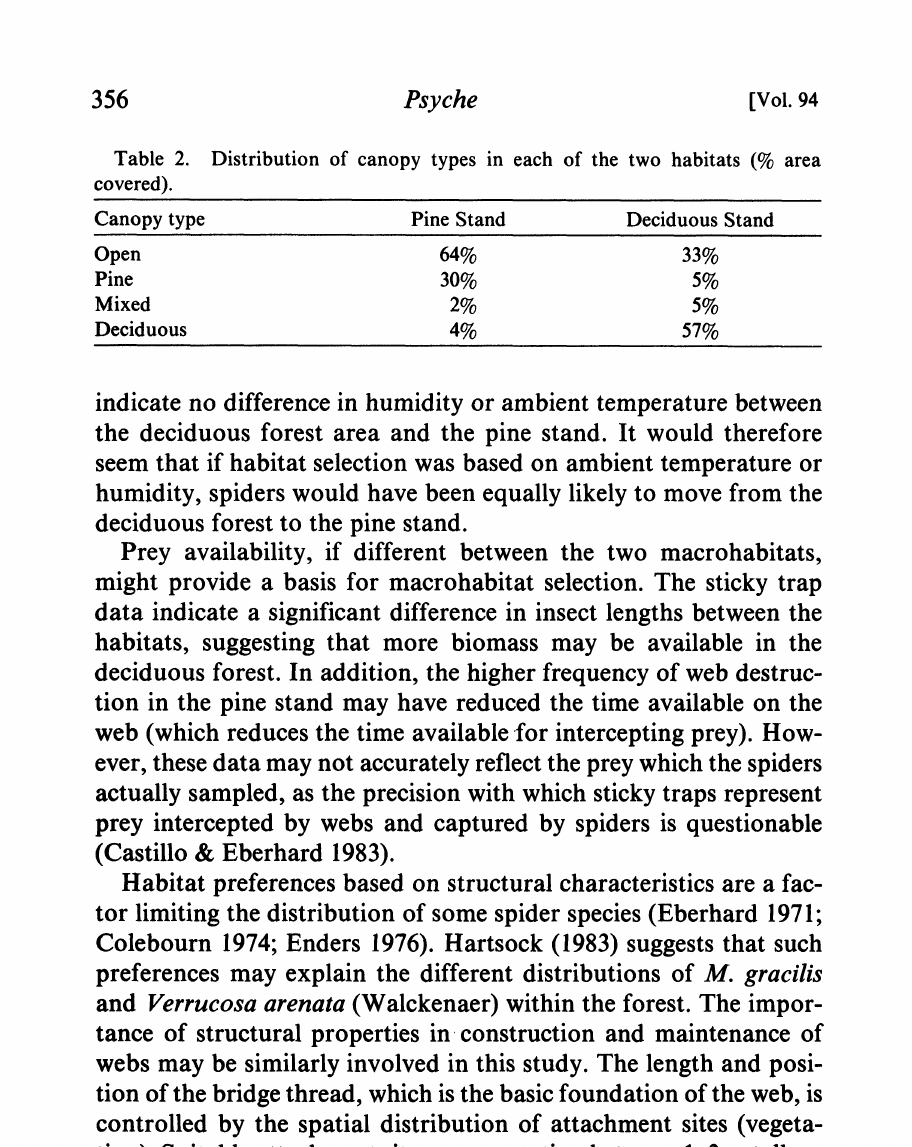
Table 2. Distribution of canopy types in each of the two habitats (% area